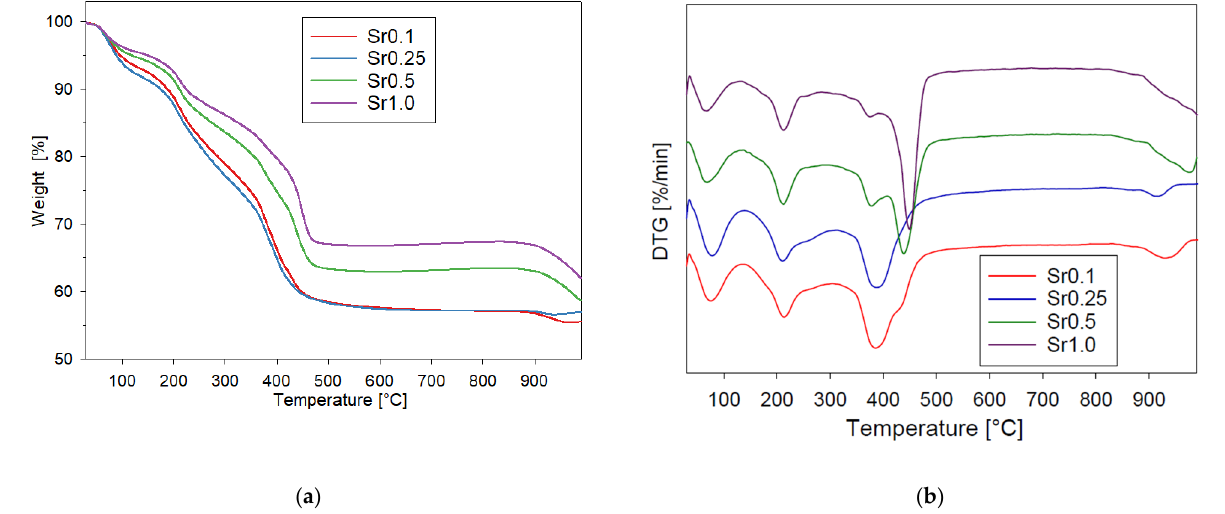
Figure 7. ( a ) TGA weight loss, and ( b ) DTG curves of Al 2 O 3 -SrCO 3 xerogels obtained with a metallic strontium precursor.